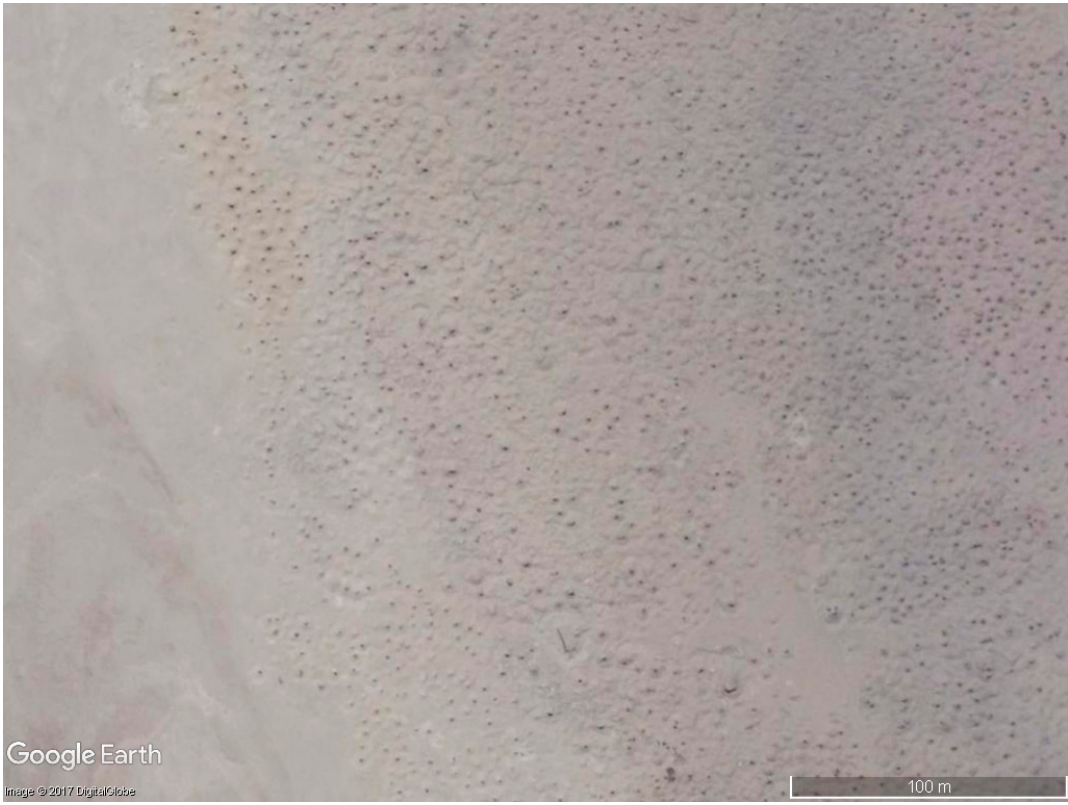
Figure 2. Satellite image of Abusir el Malik, taken 8 August 2017. Imagery courtesy of Google Earth.